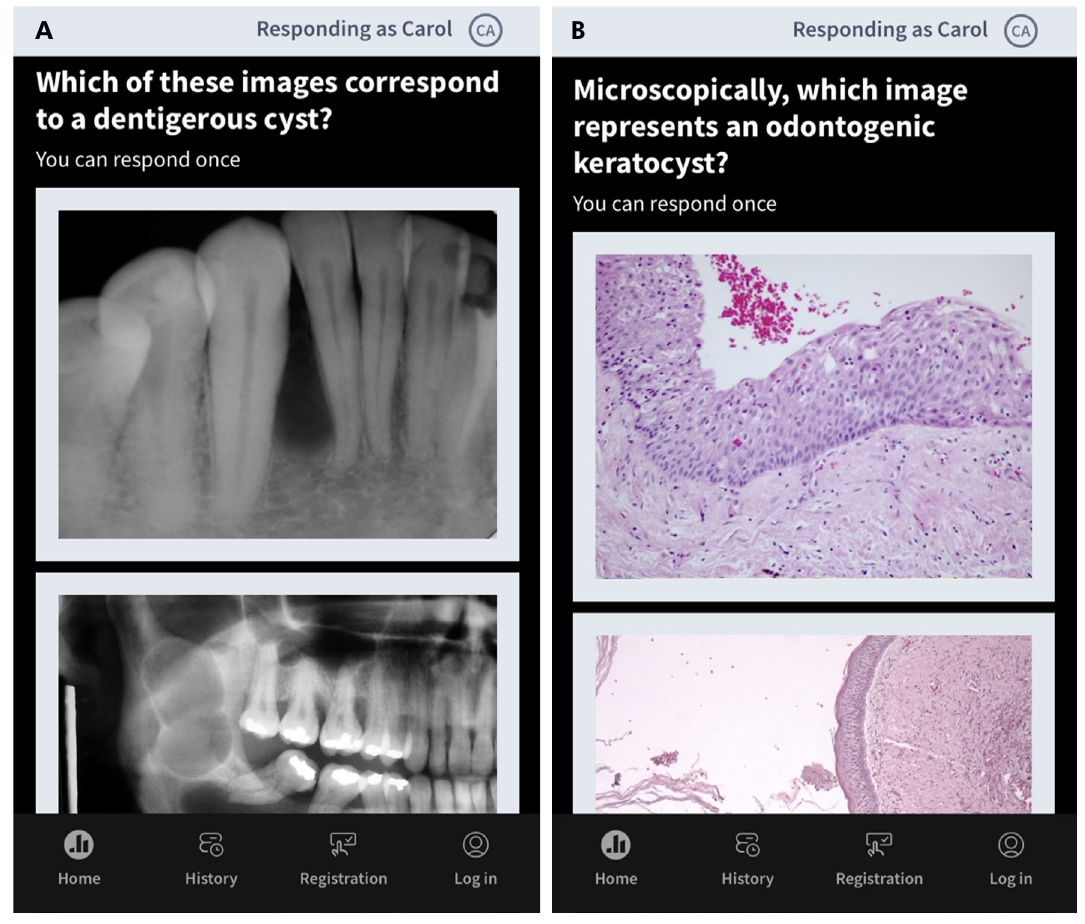
Figure 2. Questions presented to students on their mobile phones, using the Poll Everywhere app. The student must click on the figure corresponding to the correct answer. A - Question presented in Figure 1A. B - Question presented in Figure